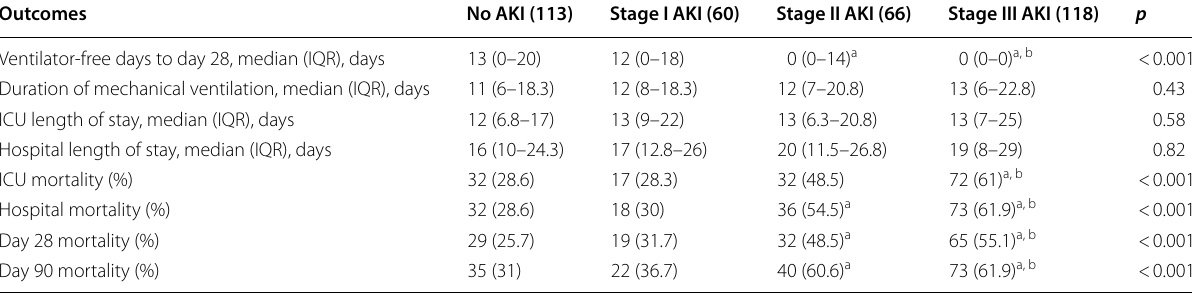
AKI acute kidney injury, ICU intensive care unit, IQR interquartile range a p < 0.05 when compared with patients without AKI b p < 0.05 when compared with patients with stage I AKI